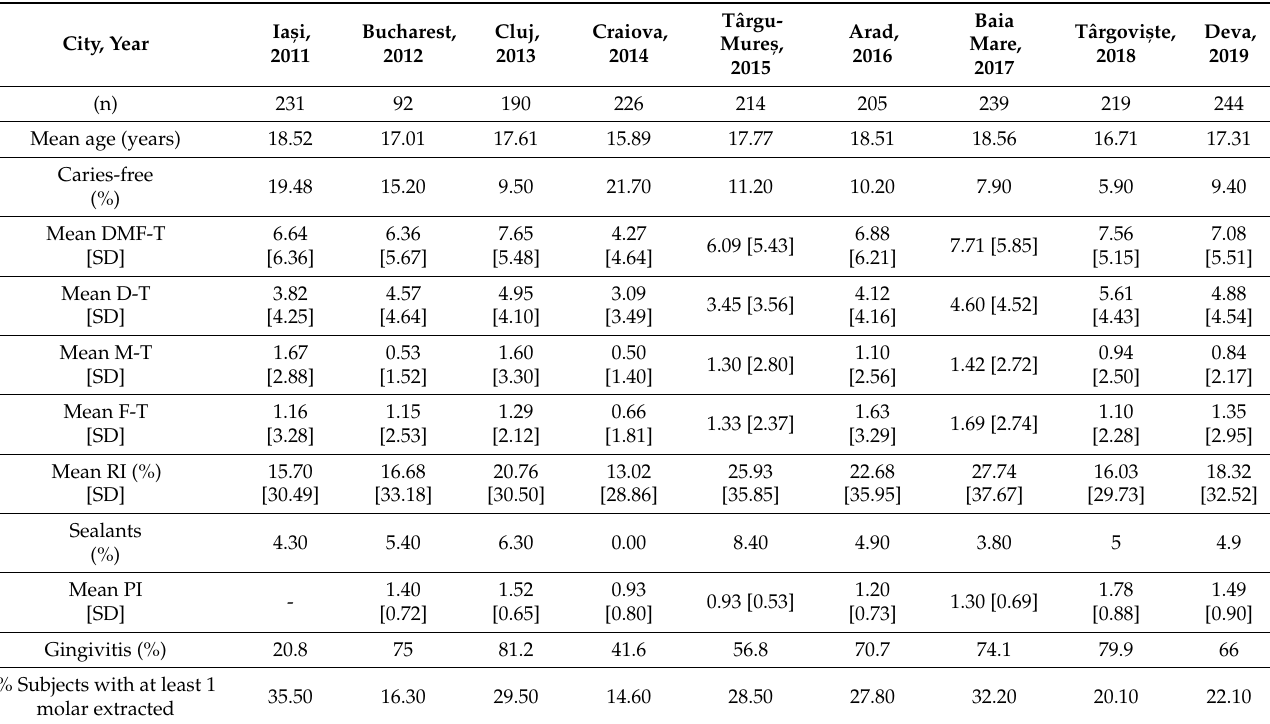
Table 2. Descriptive data analysis regarding the oral health status of Romanian SO